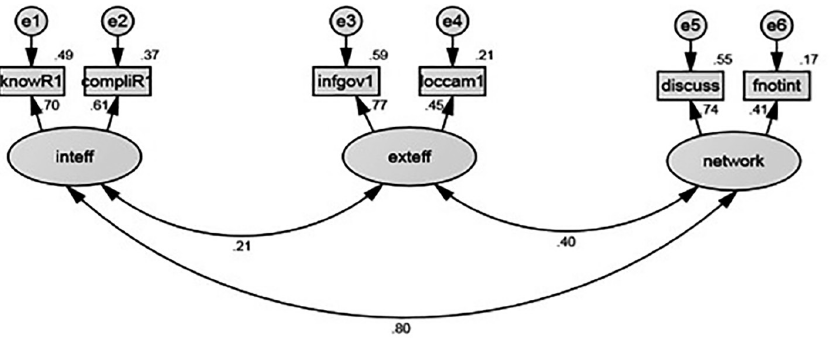
Figure 2: Con fi rmatory factor analysis: internal political e ffi cacy, external political e ffi cacy and social and political environment (standardised results). Chi-square 240.020 (6 d.f.), p=.000, RMSEA =.055, CFI =.974. Source: CITS 2011 (Online responses),